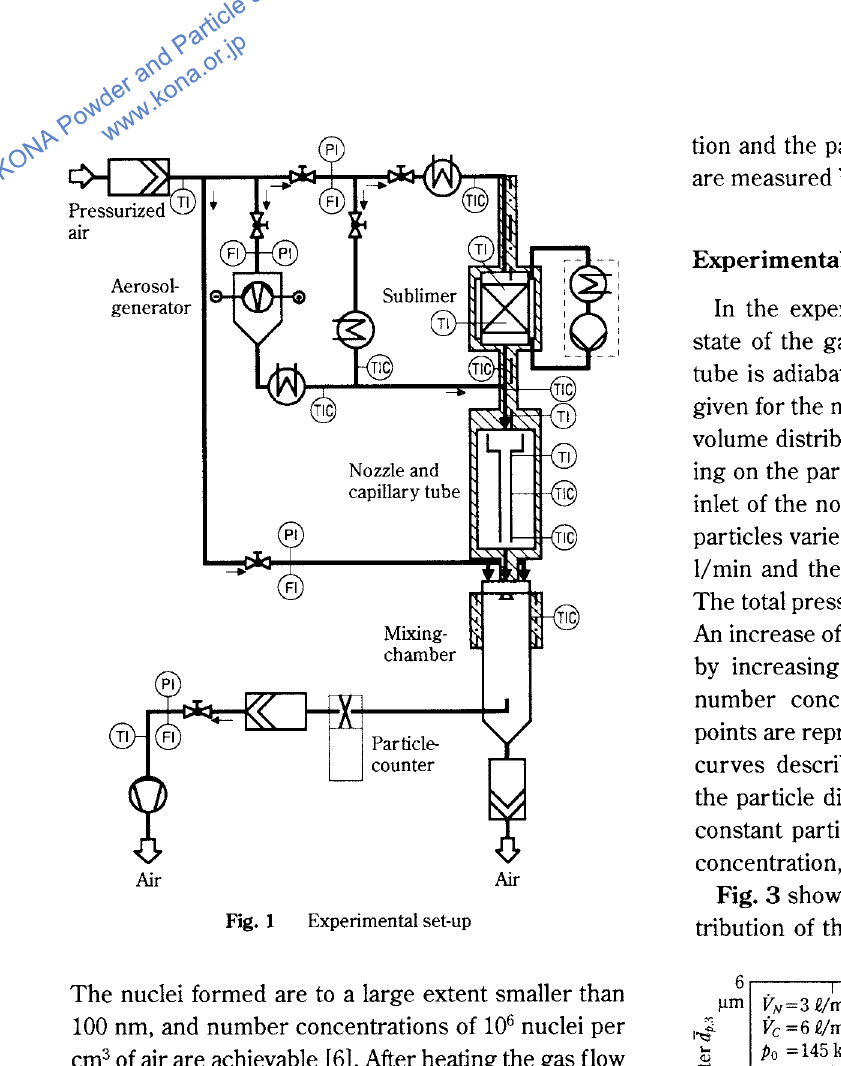
Measured mean particle diameter of the generated powder